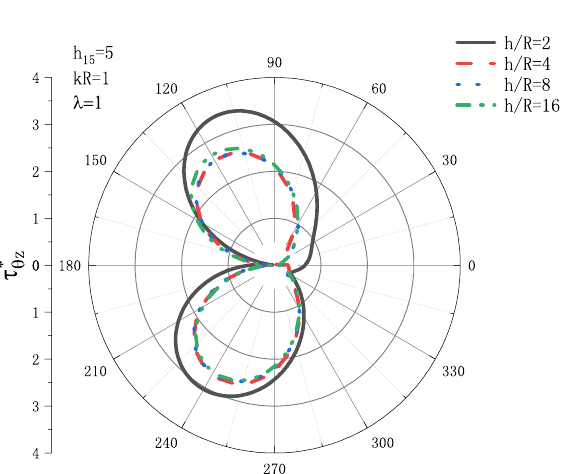
R when incident frequency kR = 0.1 . (cid:31)